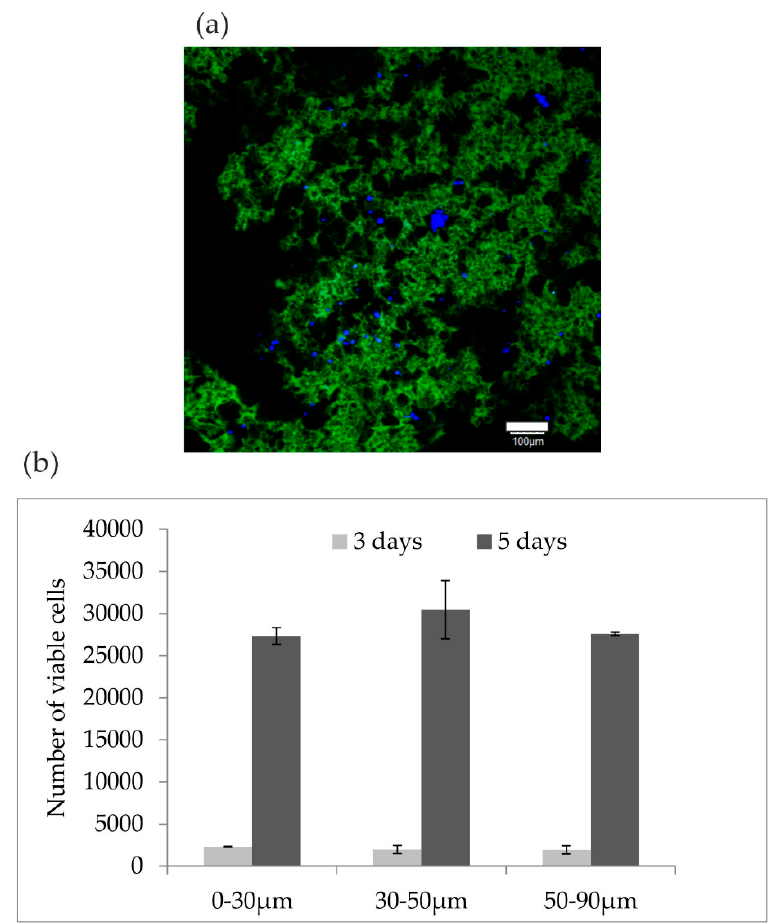
Figure 7. ( a ) rMSC growth on the HPMA-based hydrogel scaffold with porogen 30–50 µm was determined by LSCM after 5 days and visualized using cell nuclei fluorescence (blue spots). Green structures are the gel scaffold fluorescence visualized due to the presence of fluorescein in the polymer structure. ( b ) The average number of viable cells growing on the gel scaffolds at day 3 and 5. The amount of initially plated cells was 1 × 10 5 per scaffold sample. The growth of rMSC in larger pores is documented by a movie from the LSCM images in ESI. LSCM allows one to focus on levels below the material surface; in this case, cells as deep as 100 µm could be observed within the scaffold bulk.